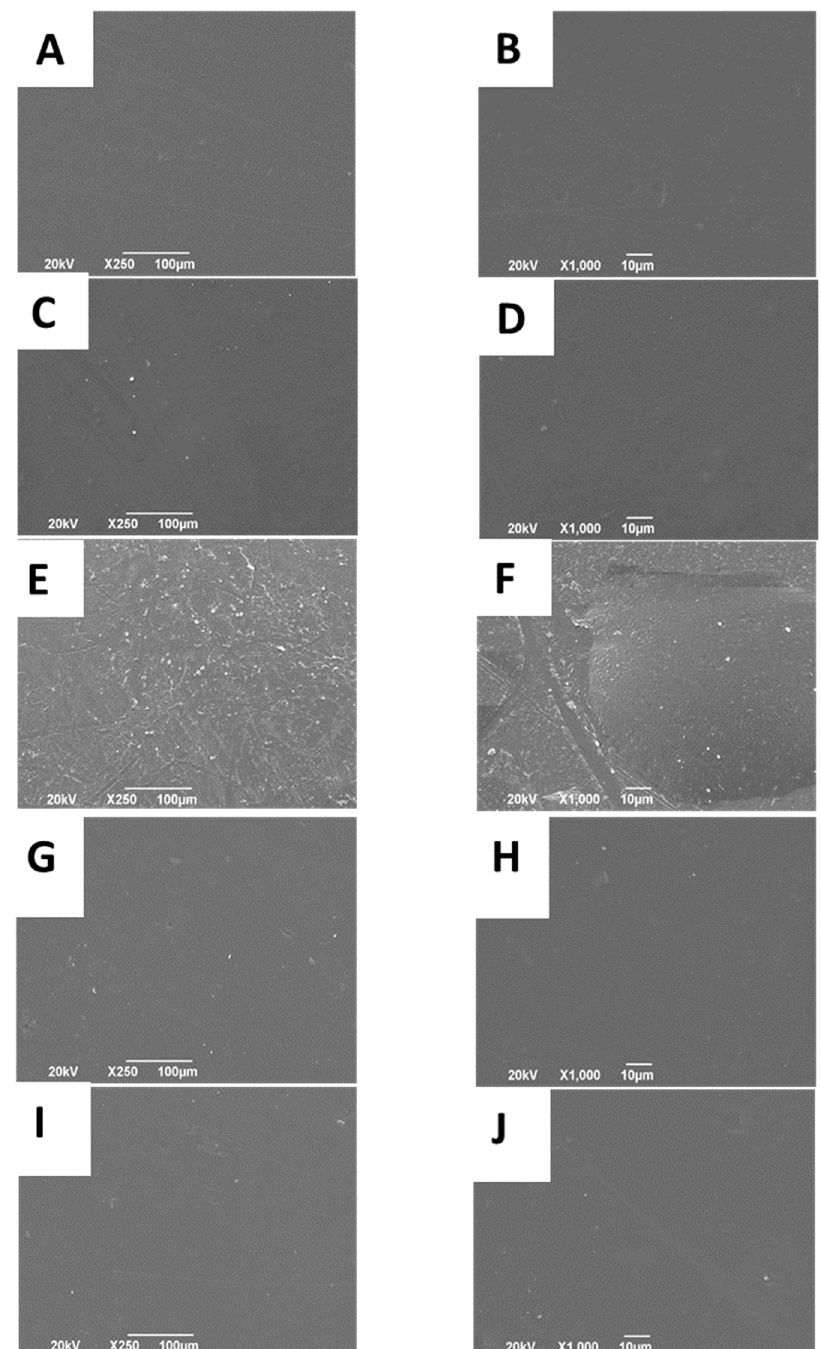
Figure 8. Morphology of the films: F1 (CS: PVA:ox-CNO 30.00:70.00:0) ( A ) at 250×, ( B ) at 1000×; F2 (CS:PVA:ox-CNO 29.50:70.00:0.50) ( C ) at 250×, ( D ) at 1000×; F3 (CS:PVA:ox-CNO 29.00:70.00:1.00) ( E ) at 250×, ( F ) at 1000×; F4 (CS:PVA:CS-g-CNO 29.50:70.00:0.50) ( G ) at 250×, ( H ) at 1000×; F5 (CS:PVA:CS-g-CNO 29.00:70.00:1.00) ( I ) at 250×, and ( J ) at 1000×.